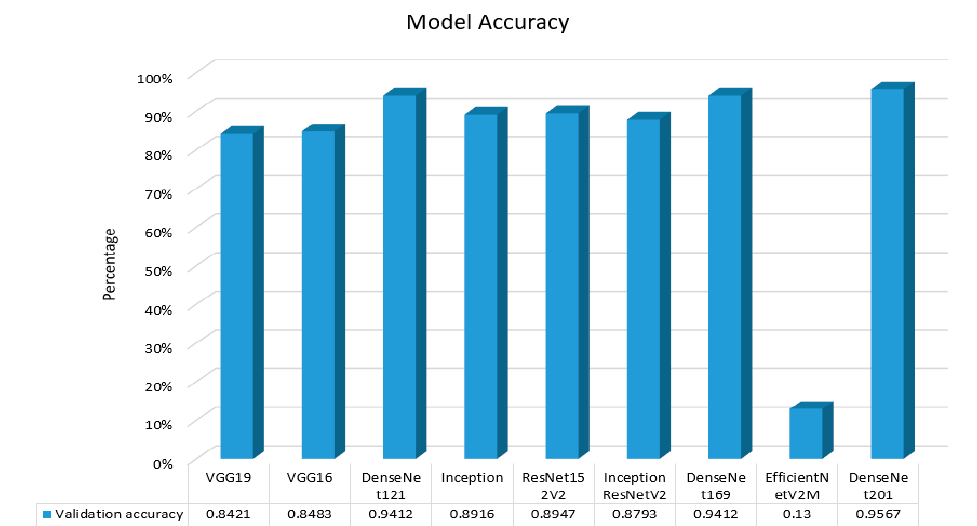
Figure 32. Transfer learning models’ accuracy.